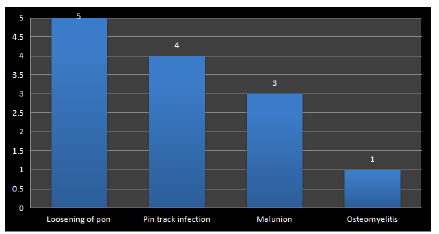
Figure 13. Distribution of study subjects according to complication